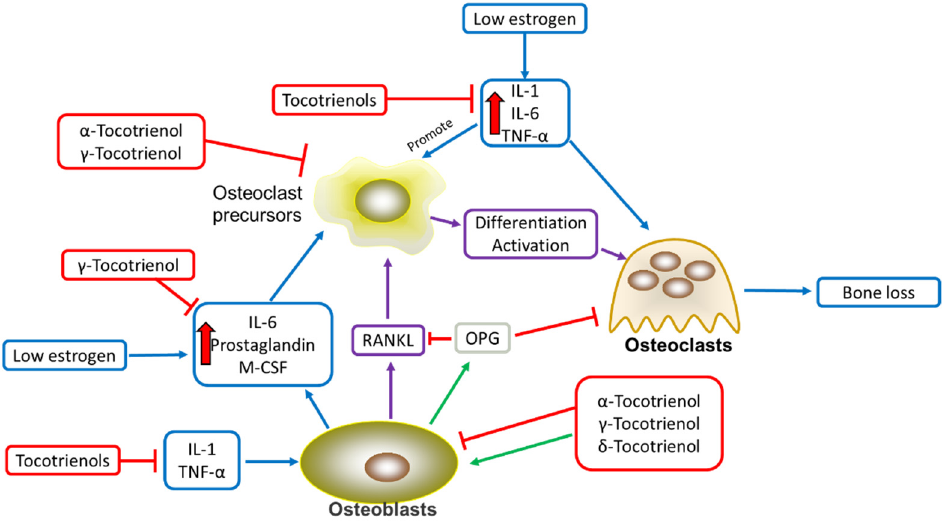
Figure 2. The effects of inflammatory mediators on bone cells and bone remodeling and the countereffect of tocotrienols.